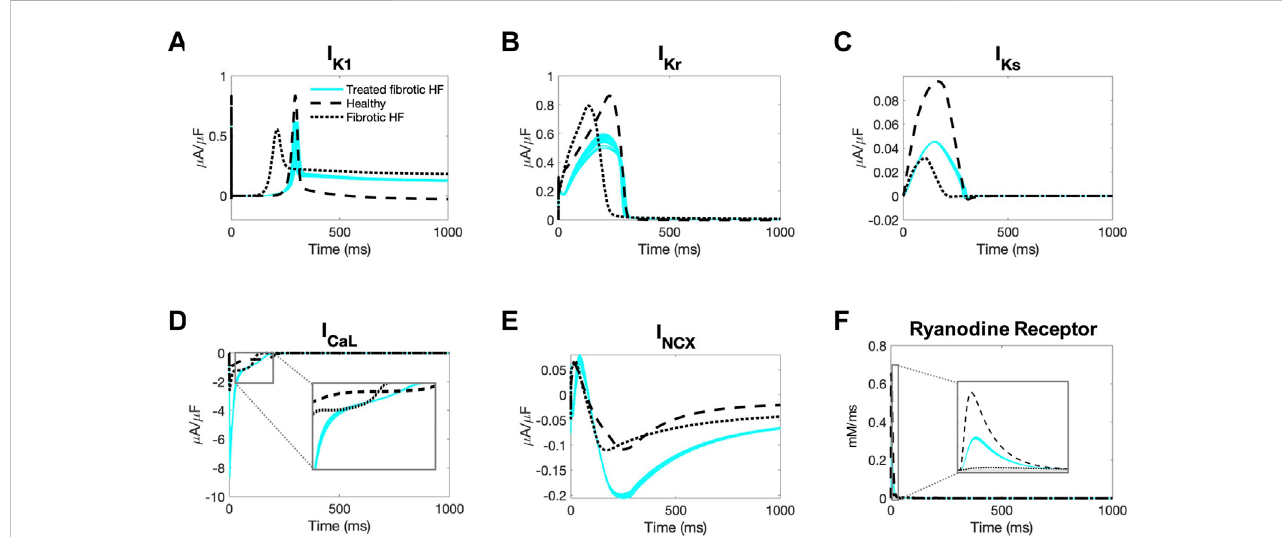
FIGURE 6 Ionic currents of fi brotic heart failure cardiomyocytes during heterocellular coupling with accepted custom cells. Plots of the following ionic currents of fi brotic heart failure (HF) cardiomyocytes when coupled to 25 randomly selected accepted custom cells (blue) that express cardiomyocyte inward recti fi er channel: (A) inward recti fi ercurrent (I K1 ); (B) rapiddelayedrecti fi er (I Kr ); (C) slowdelayed recti fi er (I Ks ); (D) L-typecalcium(I CaL ); (E) sodium-calciumexchanger (I NCX ); (F) ryanodine receptor. Zoomed in views of currents for I CaL and ryanodine receptor are inset. Healthy and untreated fi brotic HF cardiomyocytes are shown as dashed and dotted lines,